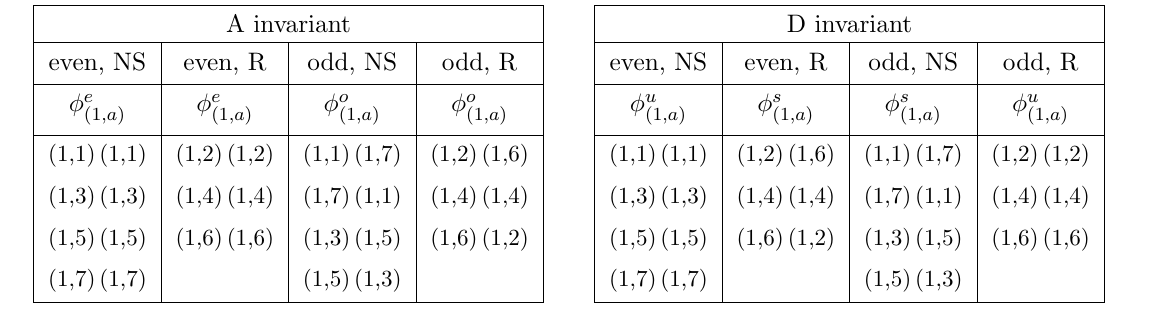
Table 18 . The (cid:12)eld content of the A and D invariants of M 3 ; 8 (even part of the table) and their fermionic extensions (even and odd part). The fermionic extensions di(cid:11)er only in their Ramond sector parity. Listed are the parity and spin grade, the notation of the primary bulk (cid:12)eld used in section 4, and the Kac-label of the left/right representation of that